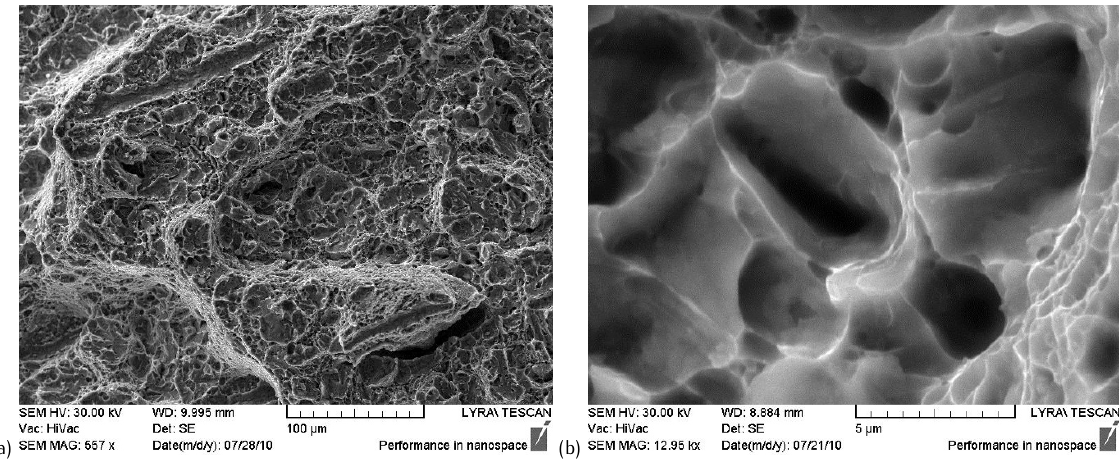
Figure 9. Fracture at surface of Charpy V-notch specimens 20 ◦ C: fracture containing bainitic-martensitic structure (a), (b).